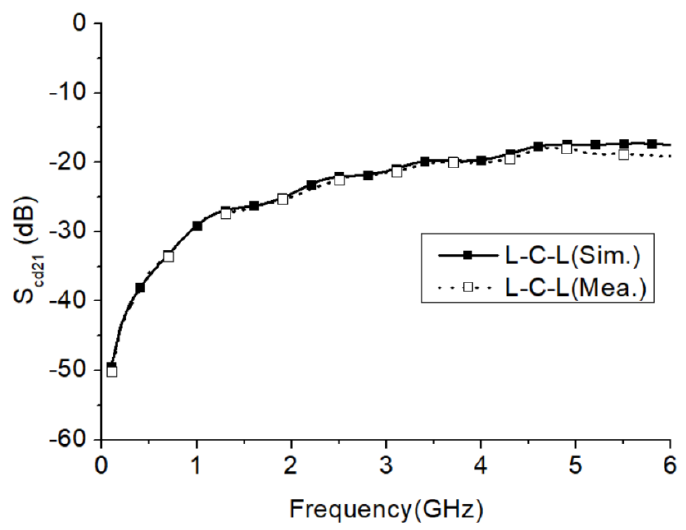
Figure 16. Comparison of the measured and simulated results for Scd21.